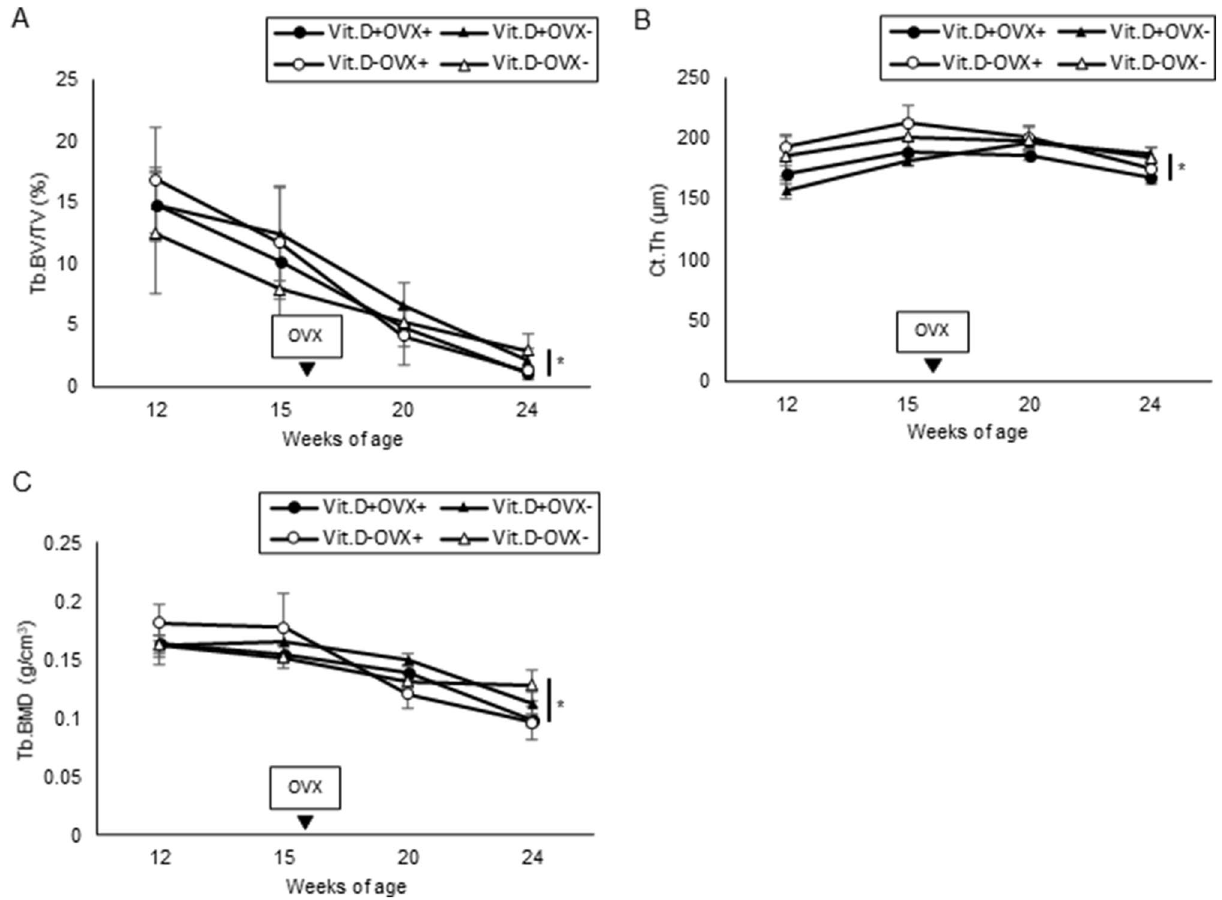
Figure 3. Bone morphological parameters by micro-CT analyses in preliminary study. Each parameter was measured using micro-CT at 12 weeks of age (initiation of diet with vitamin D–deficient or vitamin D–containing), 15 weeks, and 20, 24 weeks. ( A ) Trabecular percent bone volume [Tb.BV/TV] ( B ) Cortical thickness [Ct.Th] ( C ) Trabecular bone mineral density [Tb.BMD] * p < 0.05. CT, computed